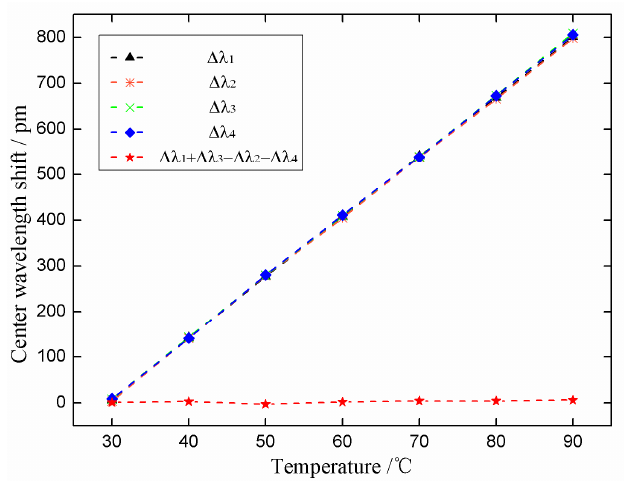
Figure 16. Temperature response curves of this sensor.